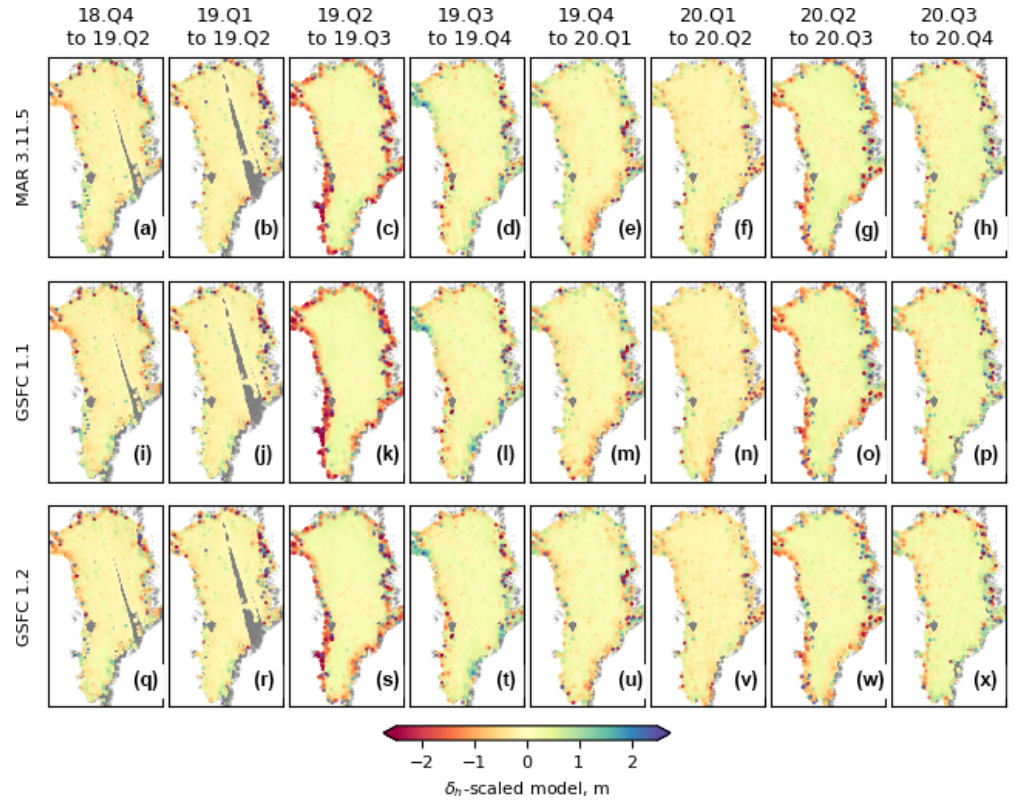
Figure 6. Residuals between measured height differences and rescaled MARv3.11.5 (a–h) , GSFCv1.1 (i–p) , and GSFCv1.2 (q–x) models. The time periods for each set of differences are indicated at the top of each column. MARv3.5.11 is rescaled by 0.61, GSFCv1.1 is rescaled by 0.66, and GSFCv1.2 is rescaled by 0.88. In each plot, the data are masked to remove areas with large velocity